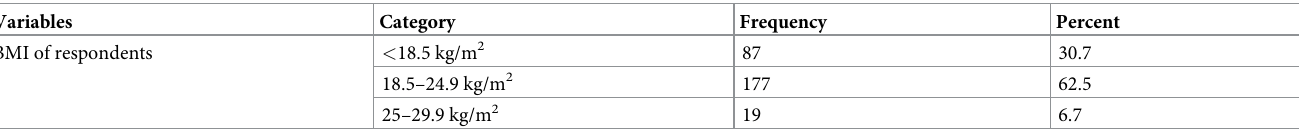
Table 2. Anthropometric measurement of adolescents in Addis Ababa city,